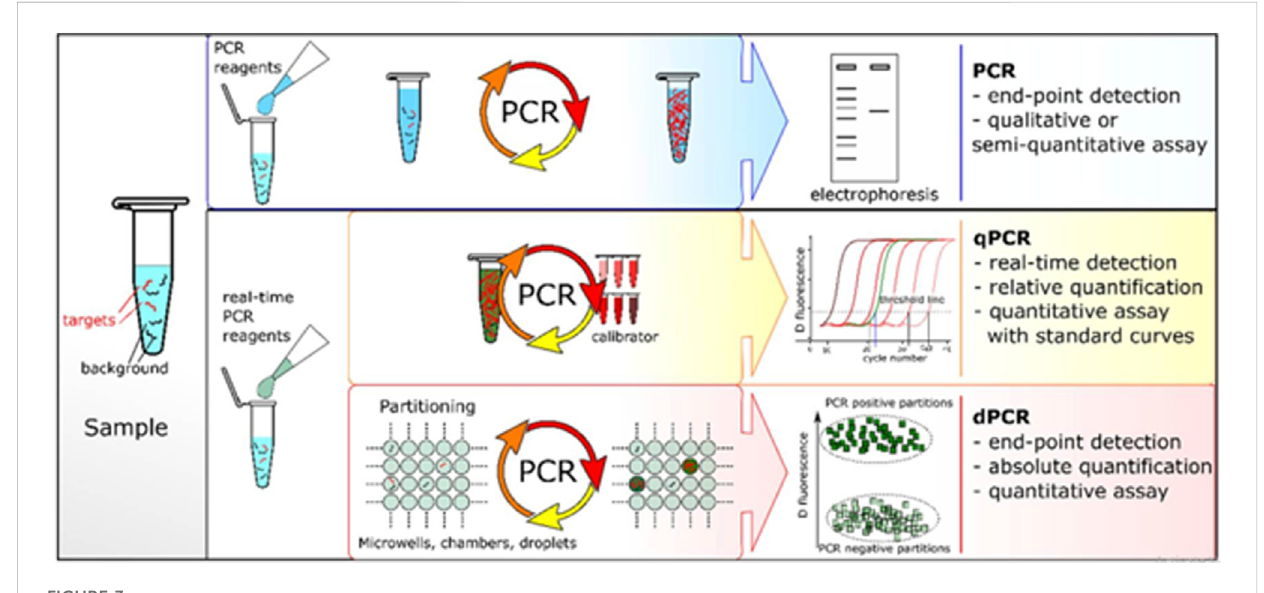
Comparison of different PCR-based techniques (Quan et al.,